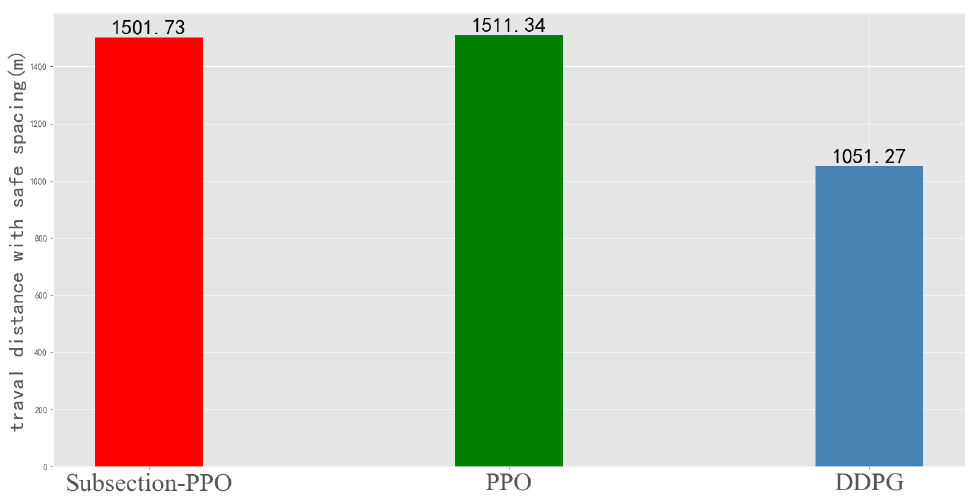
Figure 5. Driving distance with safe